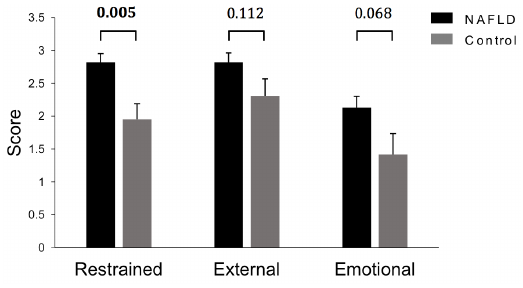
Figure 2. Eating styles in NAFLD and obese children as assessed by Dutch Eating Behaviour Questionnaires. Data adjusted for differences in BMI Z-score using ANCOVA and are expressed as estimated marginal mean ˘ standard error of the mean (SEM). NAFLD ( n = 23) Control ( n = 8).